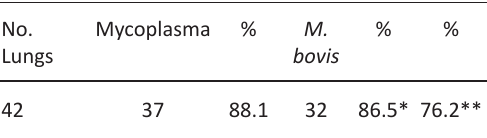
Table 4. Prevalence of Mycoplasma and M. bovis detected in pneumonic calves lung